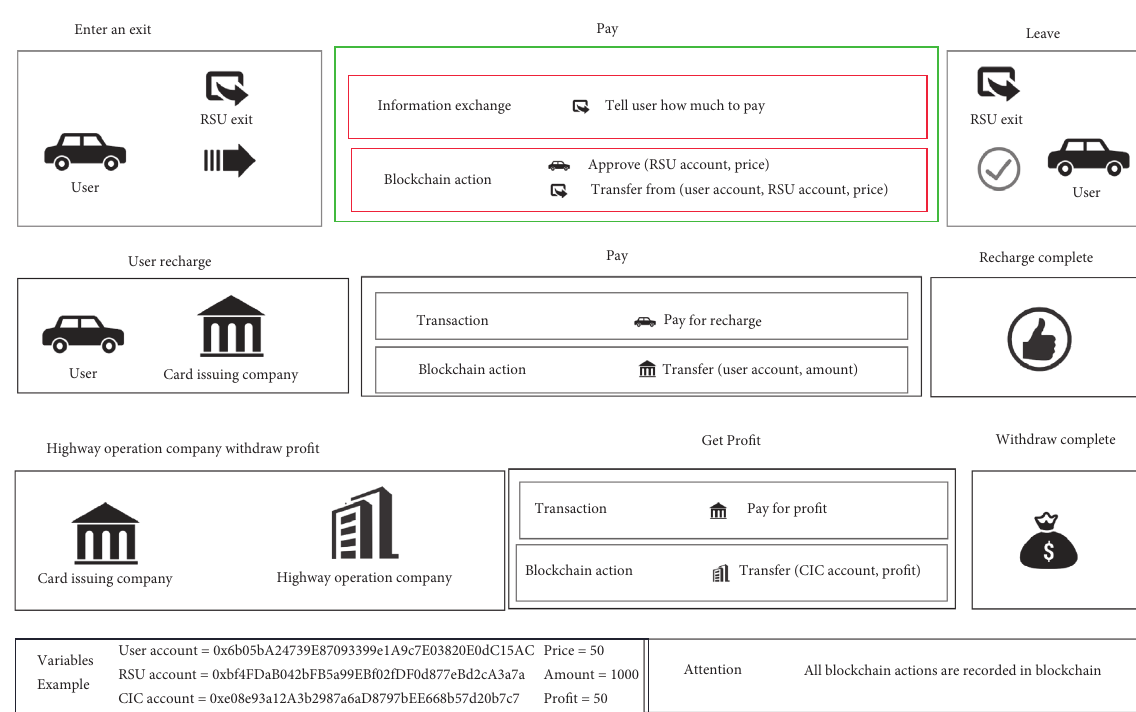
Figure 8: An implementation example of the proposed